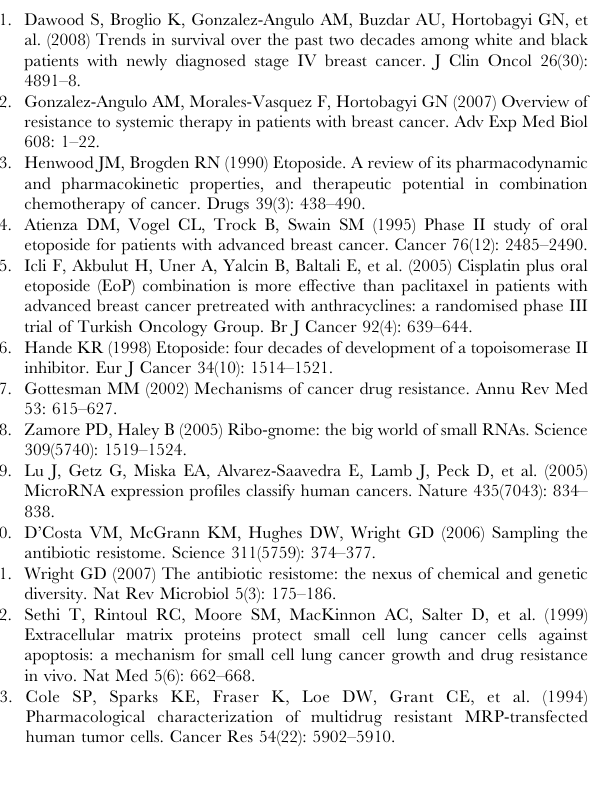
(among others). The plot was constructed using Partek genomics suite. Figure S3 Ingenuity Pathway Analysis (IPA). The figure shows a bar graph demonstrating up-regulation of genes in numerous pathways in the MCF7VP cell line including integrin signaling. (EPS) Data File S1 MicroRNA Array Data. The .xls data file contains the results of the differential expression of miRNA between the MCF7VP (MCF7.VP) and the parental MCF7 cell line